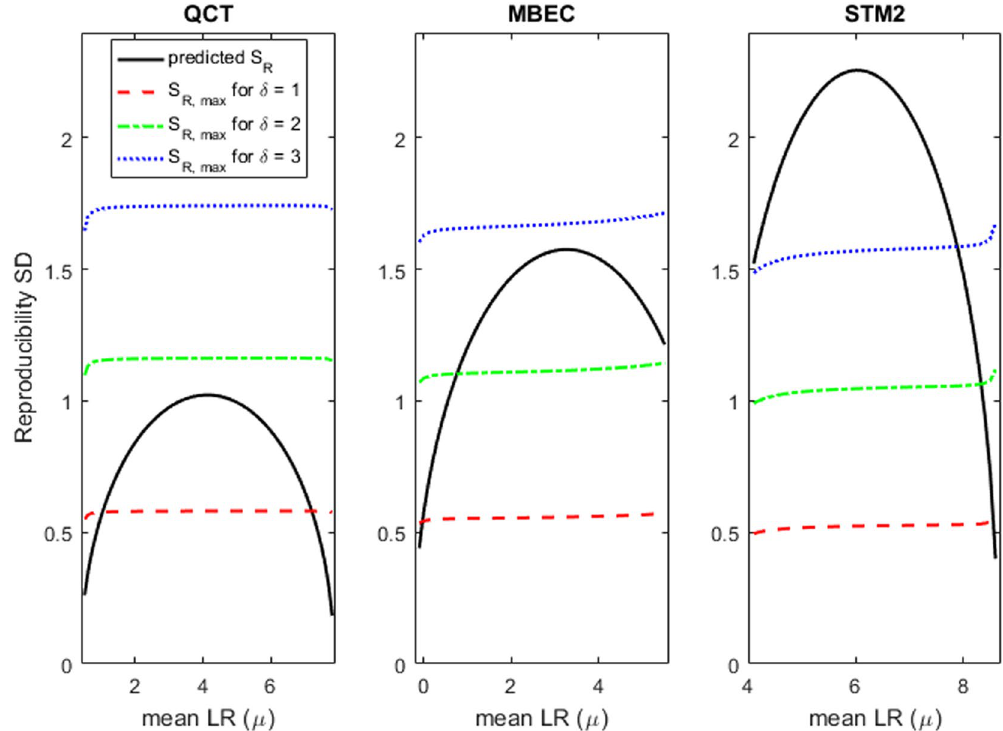
Figure 4. Assessing reproducibility of 3 antimicrobial test methods according to a stakeholder’s specifications. For a range of stakeholder specifications ( δ = 1, 2 and 3; 0 < µ < 9; and γ = 90%) reproducibility assessments are provided for 3 of the methods in Table 1. The black curves that show the predicted reproducibility SDs (S R ) are from Figs 2,3. The curves depicting the maximum acceptable S R, max were calculated from equation (1).